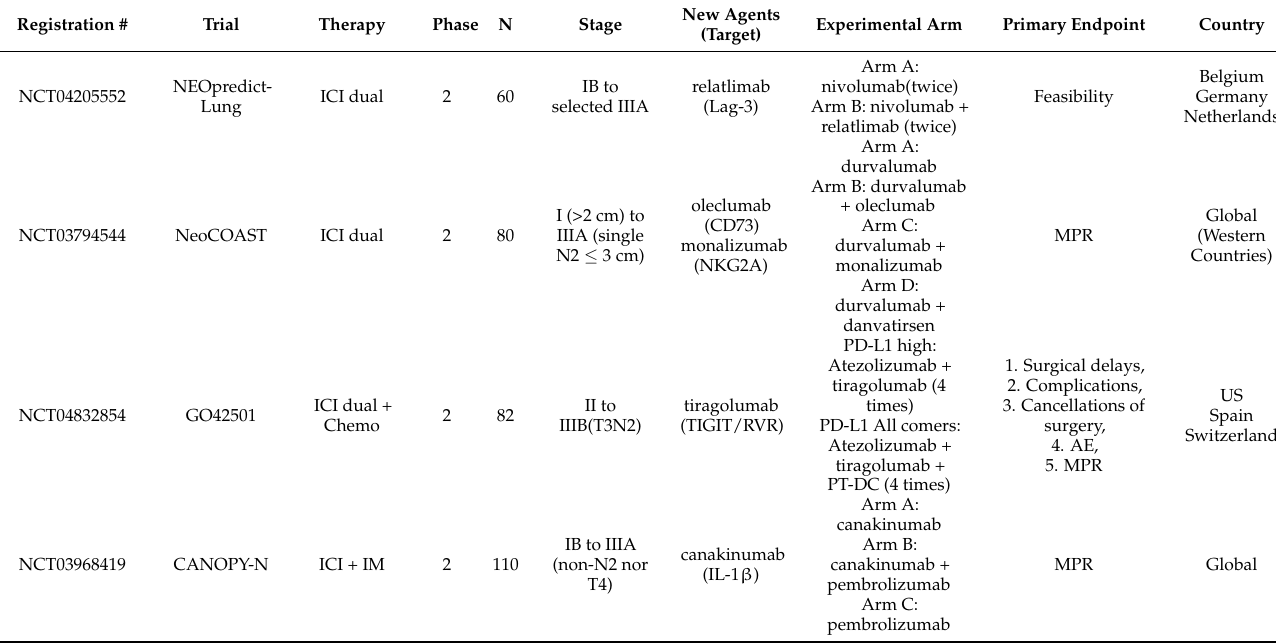
Table 4. Clinical neoadjuvant trials using new ICI